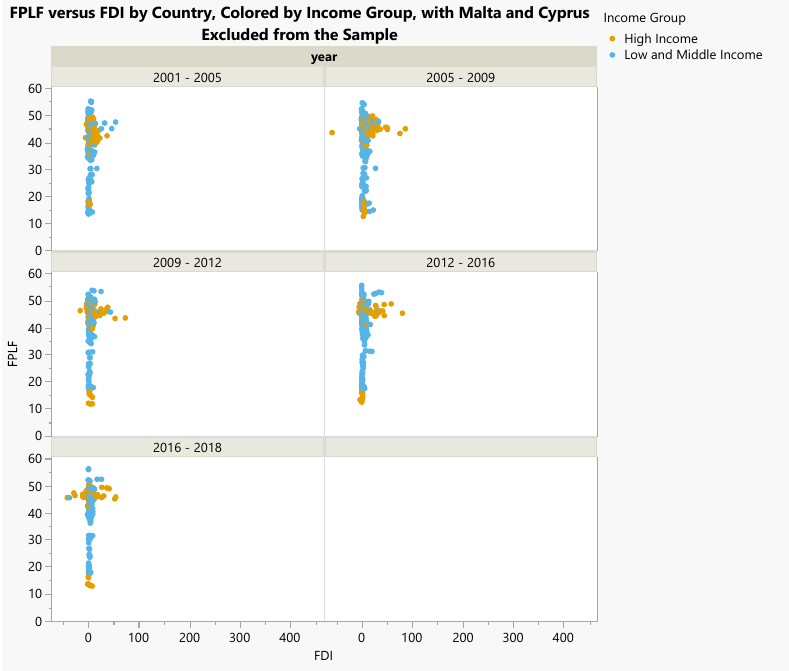
Figure 2. Scatterplots of FPLF versus FDI scaled the same as the scatterplots in Figure 1 with observations grouped in panels of 5 years and colored by income group and Malta and Cyprus excluded from the sample. Indeed, all other countries’ FDI inflows range to about 100% of their GDP maximum. Source: authors’ calculation.